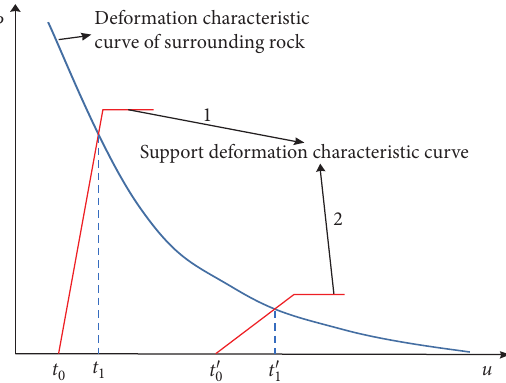
Figure 12: Interaction model between surrounding rock and support. Table 3: Stable height calculation results based on the RMR evaluation.